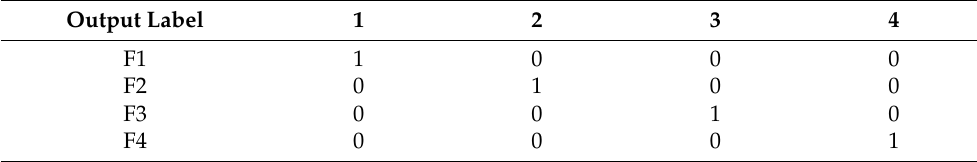
Figure 16. Spectra analysis of third component under F1 and F4. Table 2. Expected output of neural network corresponding to each state of centrifugal